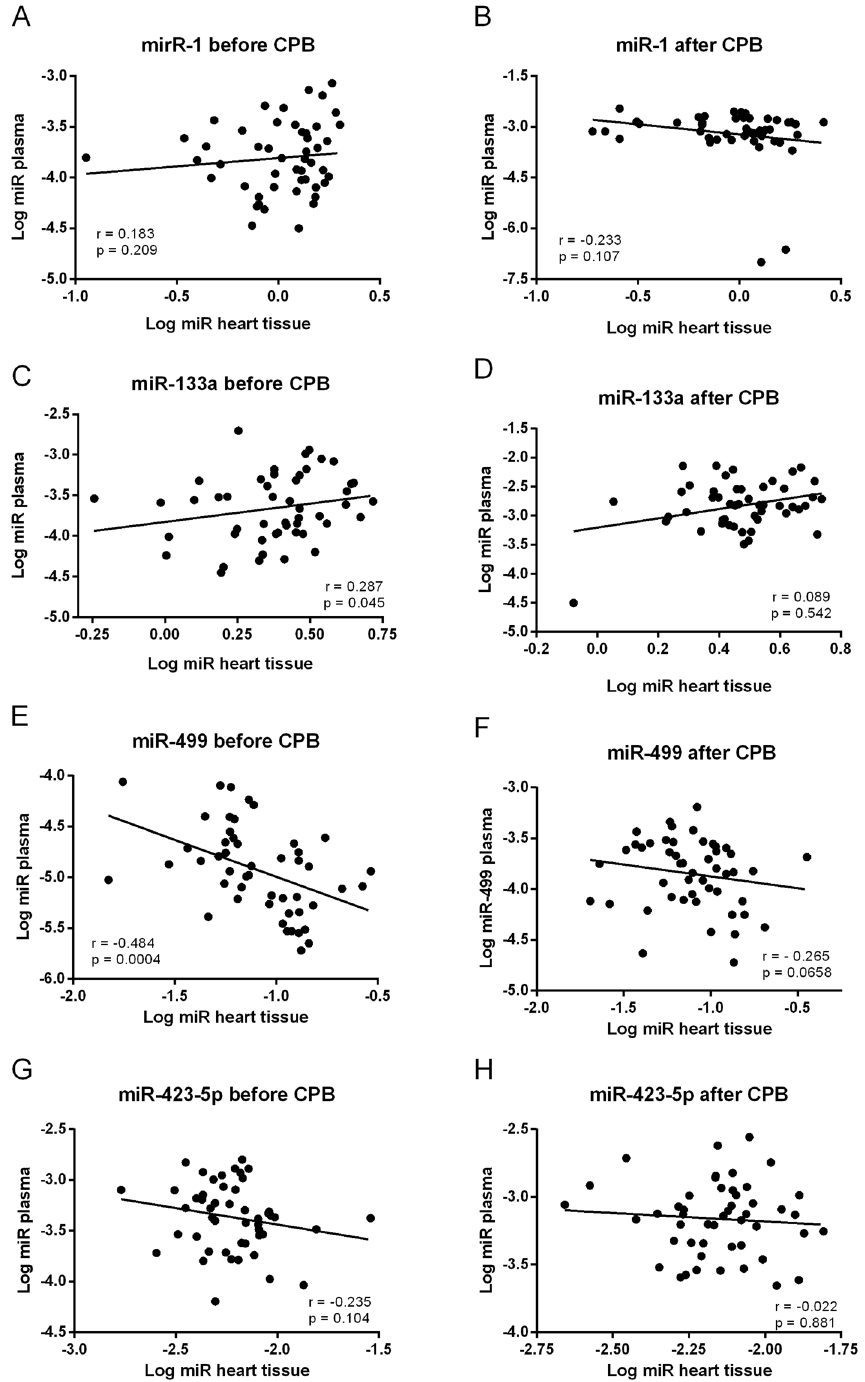
Figure 5. Correlations between plasma and right atrial miRNA expression before and after CABG. Spearman rank correlations between the plasma expression of miR-1 ( A , B ), miR-133a ( C , D ), miR-499 ( E , F ), and miR- 423-5p ( G , H ) and their respective right atrial myocardial expression in CABG patients (n = 49) before and immediately after